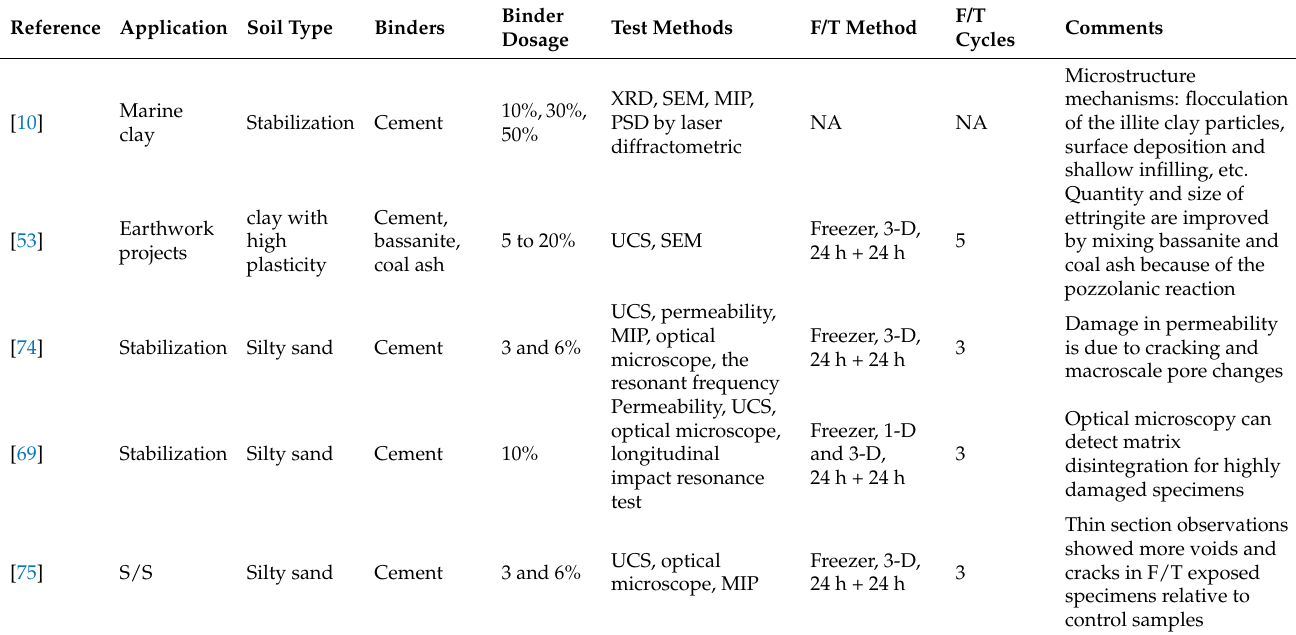
Table 3. Key references on the microscale structure of